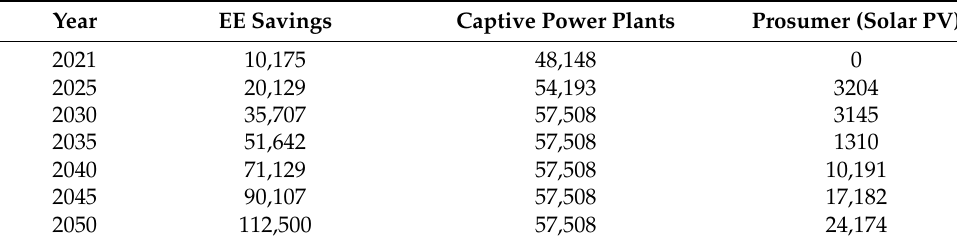
Table A2. EE, captive power plant, and prosumer forecasts (GWh).